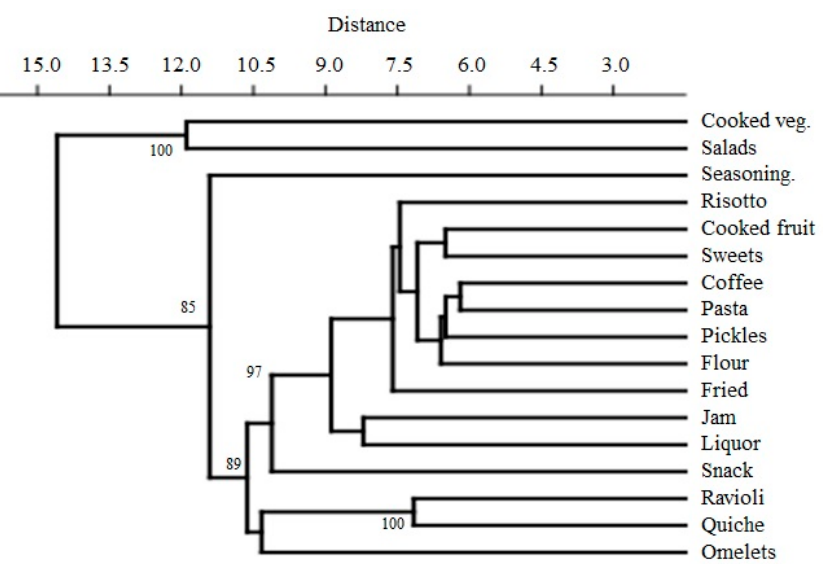
Figure 4. Cluster analysis of the different uses based on the presence/absence of taxa.